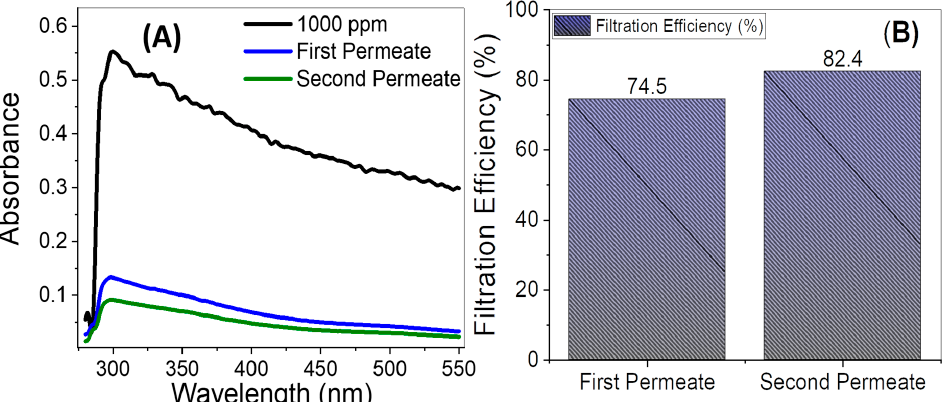
Figure 9. Double filtration-permeate ( A ) absorbance and ( B ) filtration efficiency of 1000 ppm stron- tium aqueous solution using 0.7 PES/TNR-MWCNT.